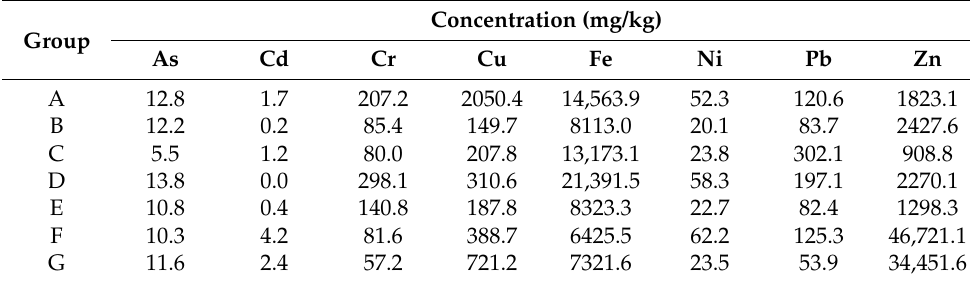
Table 6. Heavy metal content in coke for Groups